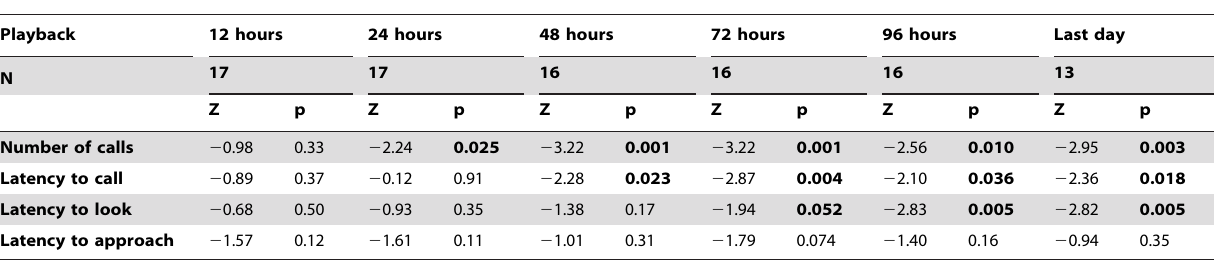
Table 2. Summary of individual behaviour